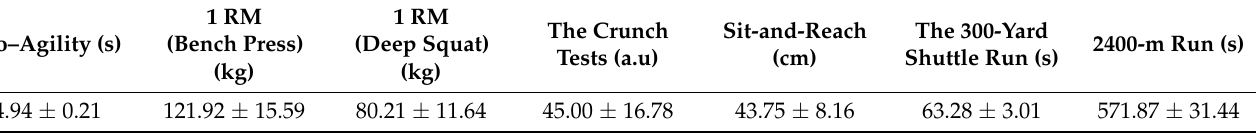
Table 1. The results of each physical performance test ( n = 10).